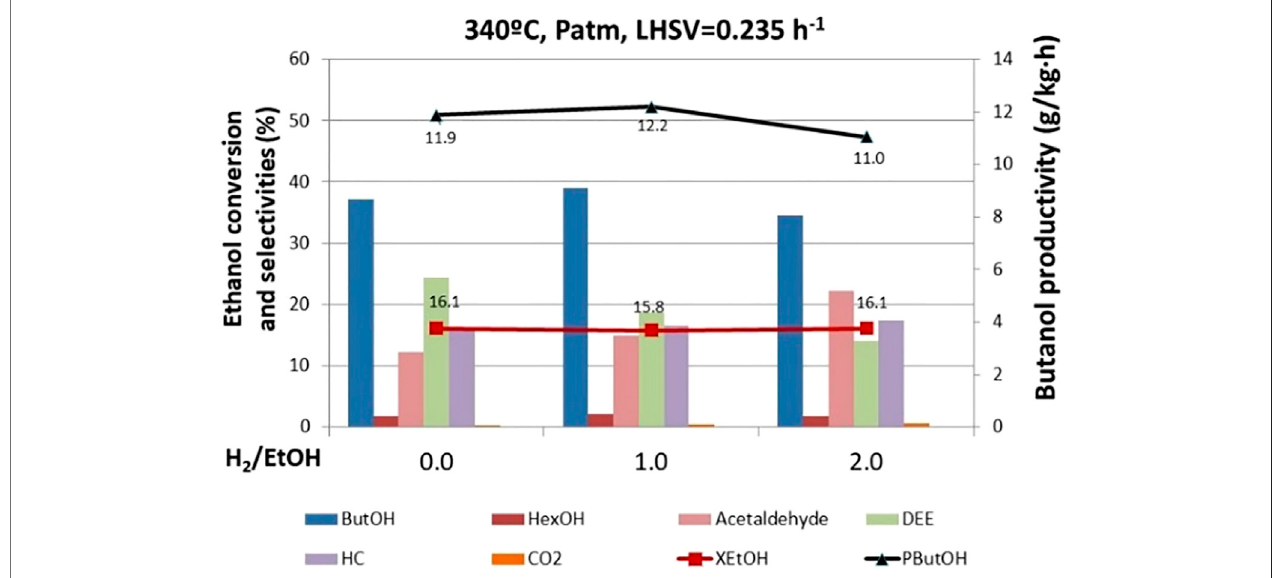
FIGURE 8 | Effect of the ratio H 2 /EtOH on ethanol conversion, butanol productivity, and selectivity to products. ButOH = butanol; HexOH = hexanol; HC = hydrocarbons; DEE = diethyl ether.